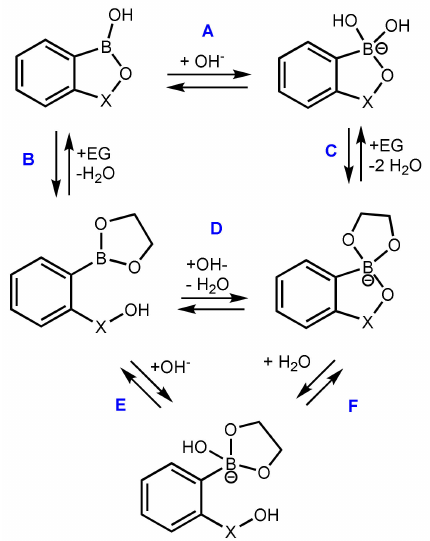
Figure 4. The equilibria for ethylene glycol (EG) binding with benzoxa- (X = CH 2 ) and benzosiloxaboroles (X = SiMe 2